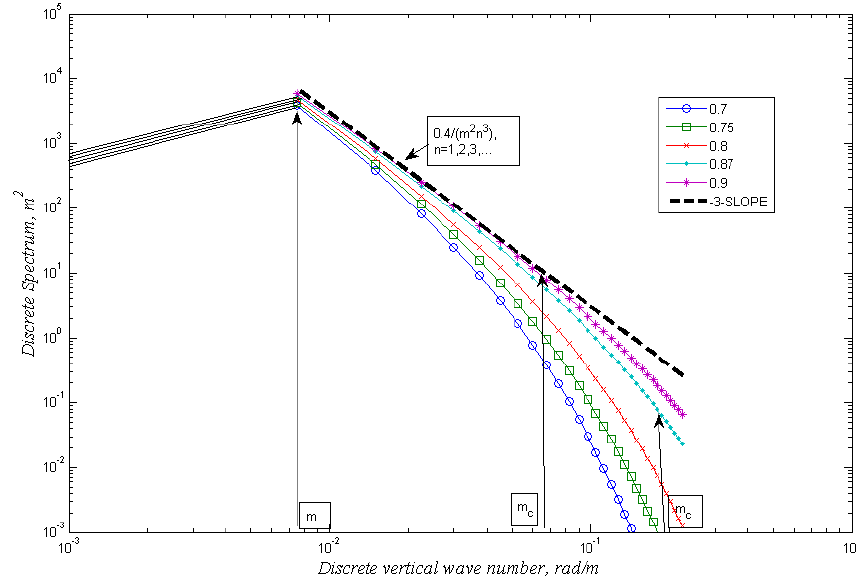
Fig. 8. Evolution of the discrete power spectrum, c 2 n , of the periodic vertical displacements (given by Eq. 52) with increasing normalized amplitude, M , of ducted gravity mode. Spectral intensities c 2 n are calculated for the discrete vertical wave numbers k z = nm , m = 0 . 0075rad/m, n = 0 , 1 , 2 ,..., and for M = ( 0 . 7 − 0 . 9 )